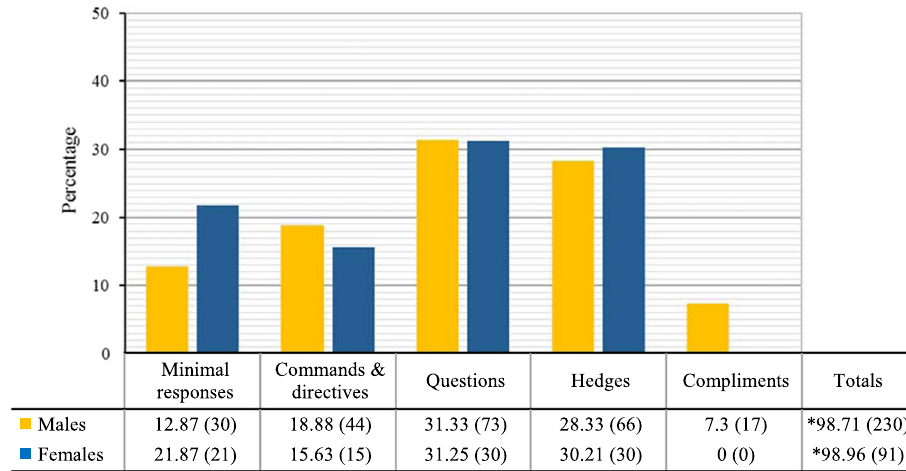
Fig. 1 Distribution of conversational strategies in Mulan-1 ( N = 325). *Totals do not equal 100% because there were three tag-questions for males and one for females.